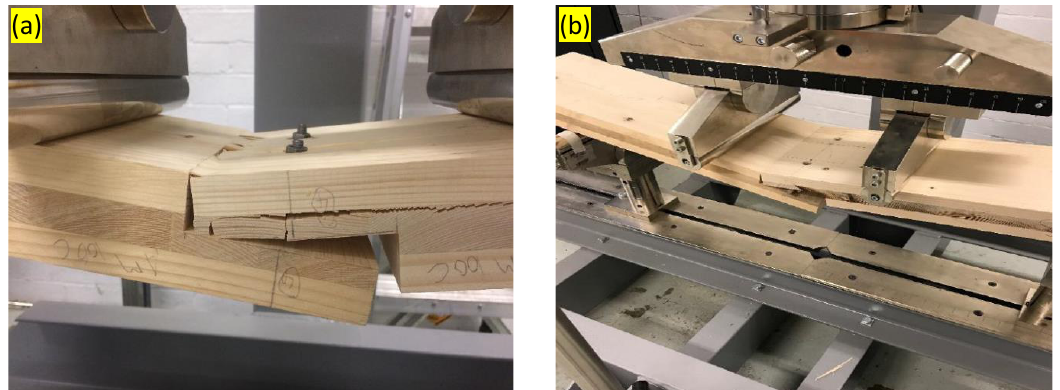
Figure 5. Failure modes associated with ( a ) bolted and ( b ) screwed lap connections.